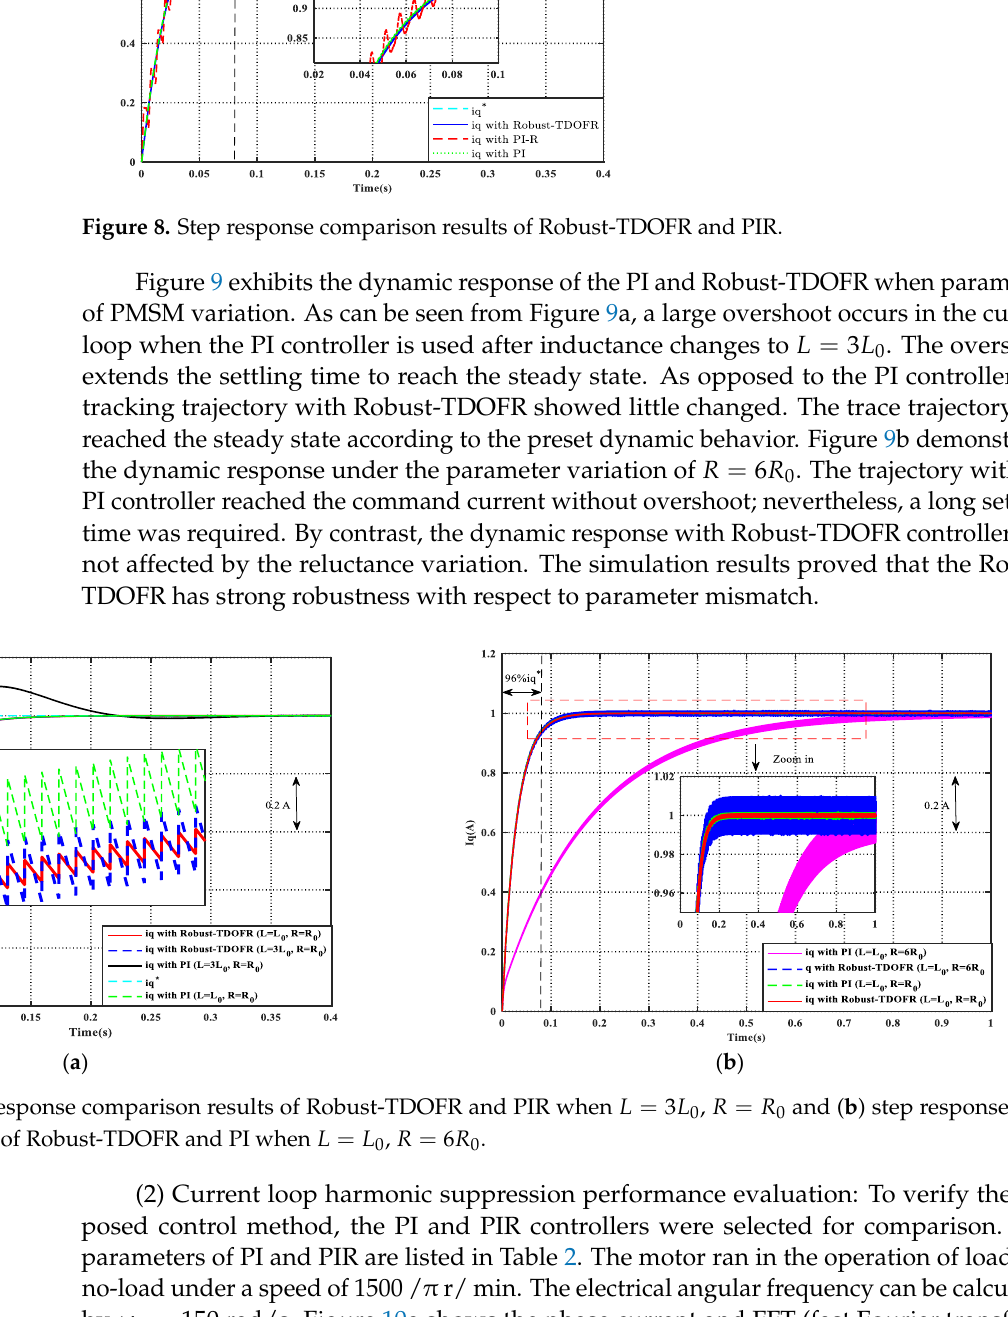
Figure 9. ( a ) Step response comparison results of Robust-TDOFR and PIR when L = 3 L 0 , R = R 0 and ( b ) step response comparison results of Robust-TDOFR and PI when L = L 0 , R = 6 R 0